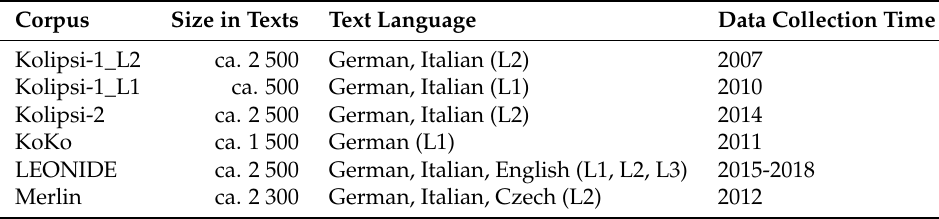
Table 1. Overview of corpora to integrate into the infrastructure Corpus Size in